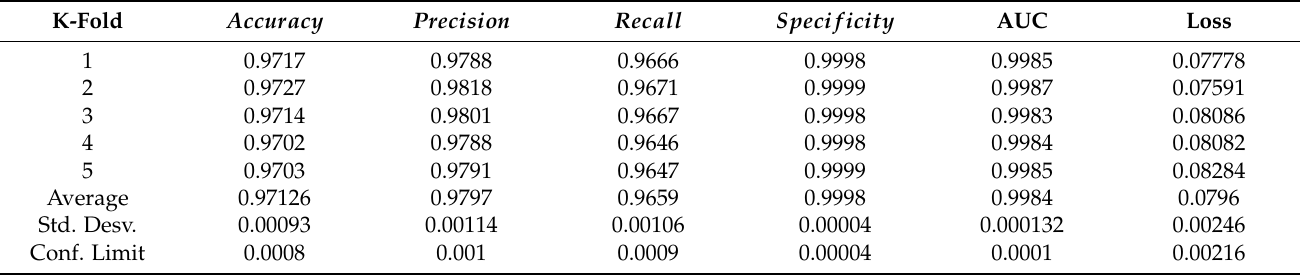
Table 6. Performance Metrics results of